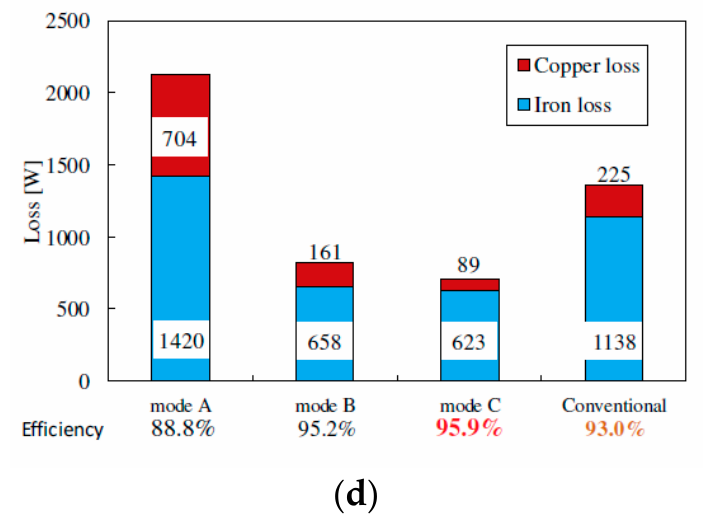
Figure 8. Calculated efficiency map in the conventional and proposed motor. Mode C can improve the efficiency by around 3% in the high-speed region. ( a ) 28 turn conventional motor, ( b ) 17-11 turn 3 mode motor, ( c ) efficiency comparison at 10 Nm 5000 rpm in each mode, ( d ) efficiency comparison at 10 Nm 15,000 rpm in each mode.